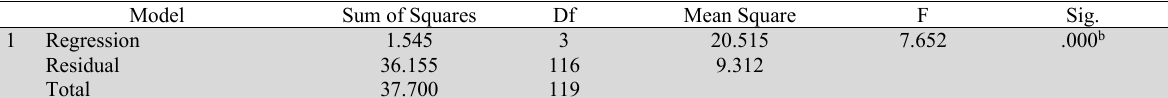
Anova a Model Sum of Squares Regression Residual